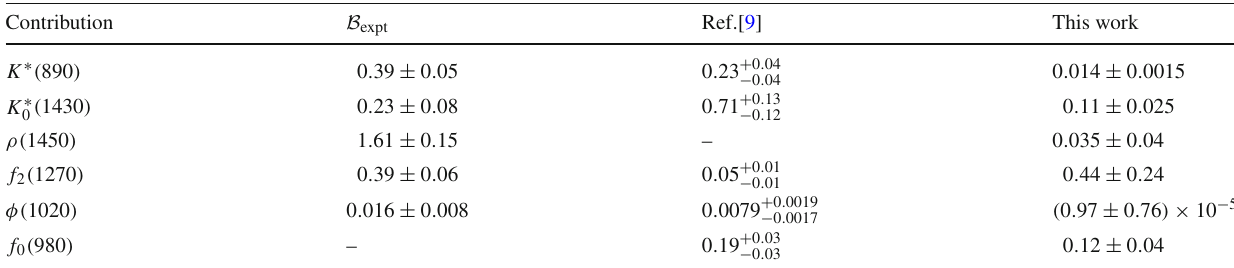
branchingfractionofeachresonance[4]andtheworldaveragedbranch- ingfractionoftheentiredecayprocess B averaged ( 5 . 24 ± 0 . 42 ) × 10 − 6 [46]